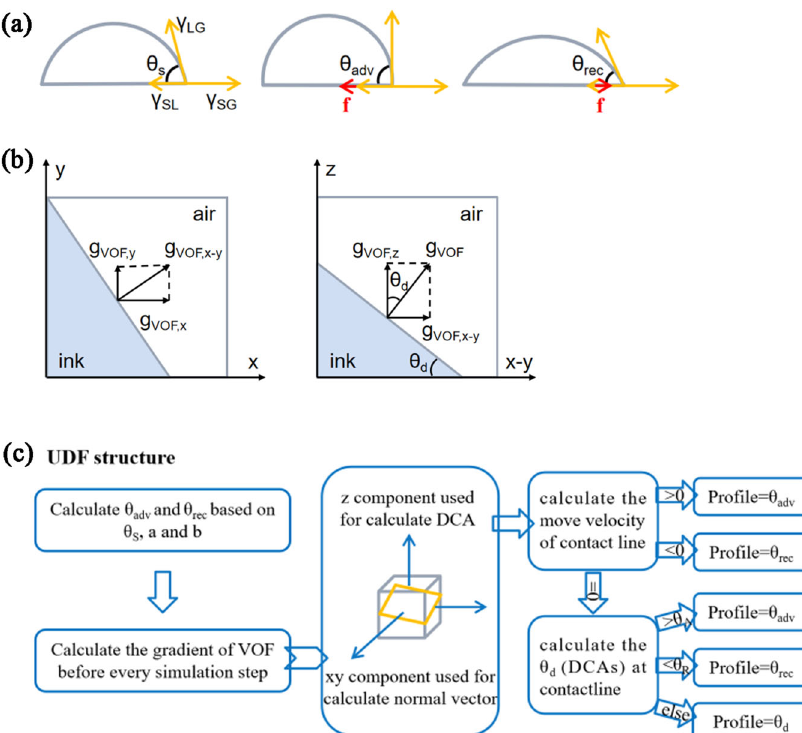
Fig. 2 Friction effect and designation of UDF. a Schematic diagram of friction tension and contact angle hysteresis. b The gradient of the VOF function from different views. c Structure of the CAH UDF. a Shows the relationship between friction effect and contact angle hysteresis, the red arrows represent the friction tension. b Shows the VOF gradients on the surface of ink fl uid, the left fi gure is the vertical view and the right fi gure is lateral